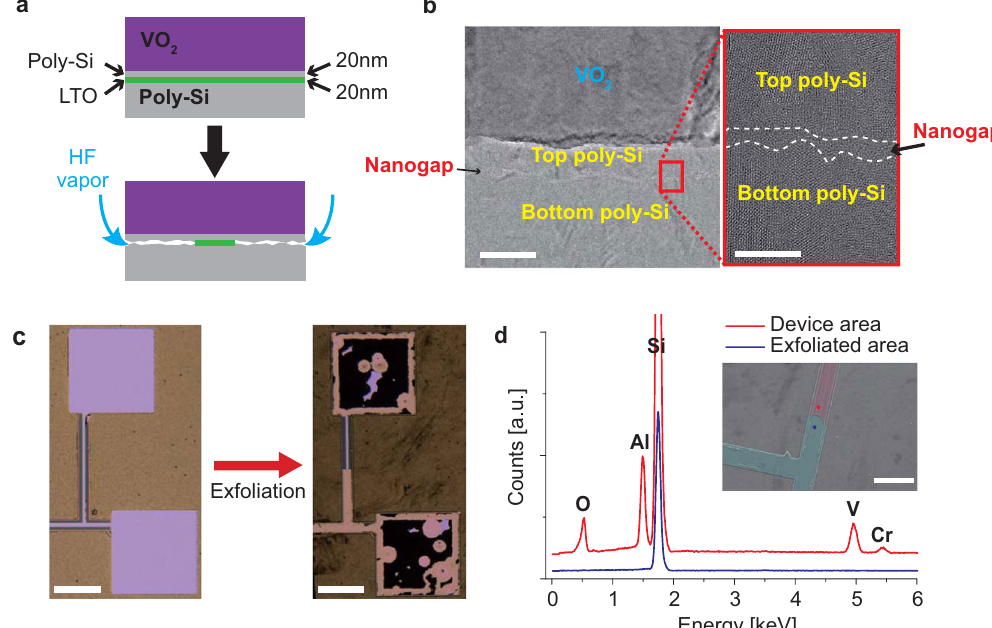
Figure 2. ( a ) Illustration of main process of the interface fabrication. The interface is formed by removal of the sacrificial LTO layer between the poly-Si layers with HF vapour etching. ( b ) Cross-sectional AC-HRTEM images of the interface area. The white dashed lines in the red box are drawn along the edge of the poly-Si layer. The continuum of atoms filling the nanogap were formed during the TEM sample preparation. Scale bar: 40 nm (left), and 8 nm (right). ( c ) Optical microscopic images of the electrodes of the thermal switch before (left) and after (right) tape exfoliation. Scale bar: 160 μ m (both left and right). ( d ) EDX spectra of exfoliated and un-exfoliated areas of the thermal switching device showing that the exfoliation indeed peels off the VO 2 layer. Inset shows SEM image of the areas where EDX spectra were taken. False colors are added in exfoliated and un- exfoliated areas for eye guidance. Scale bar: 80 μ